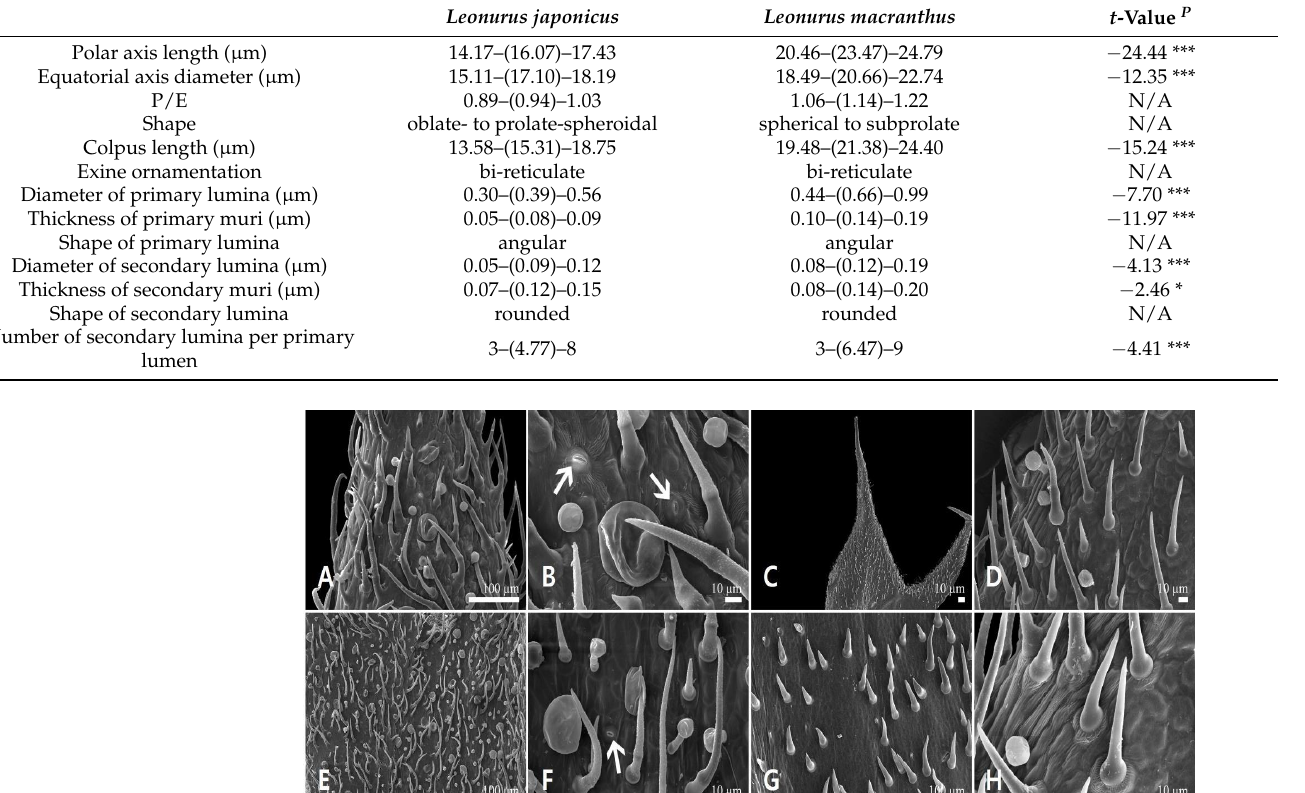
Figure 3. Scanning electron micrographs of the corolla epidermis in Leonurus japonicus . ( A , B ) Abaxial side of the upper lip. ( C , D ) Adaxial side of the upper lip. ( E , F ) Abaxial side of the lower lip. ( G , H ) Adaxial side of the lower lip.